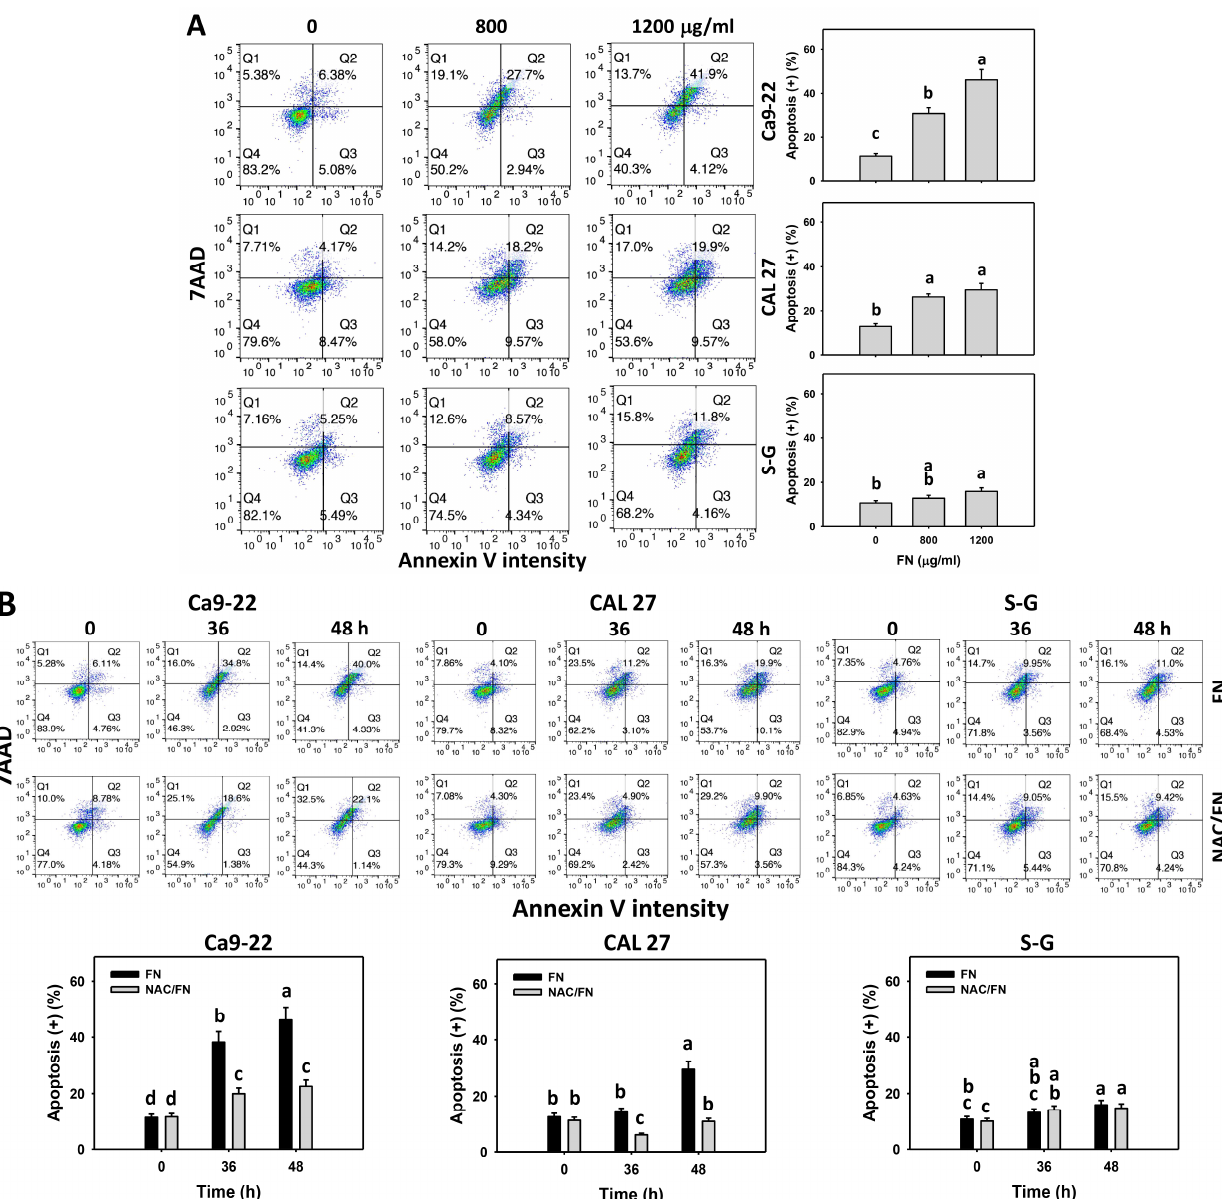
Figure 3. Fucoidan drives apoptosis (annexin V) in oral cancer cells. ( A ) Annexin V histogram and statistical analysis. Oral cancer (Ca9-22 and CAL 27) and non-malignant cells (S–G) were treated with fucoidan (control, 800, and 1200 μg/mL) for 0 and 48 h. Annexin V (+) and 7AAD (+ or −) counts, i.e., Q2 and Q3 quadrants, were regarded as apoptosis (%). It is noted that some of the Q2 cells could be necrotic and not apoptotic. Q4 and Q1 quadrants were regarded as live cells and necrosis (%). For the Q1 quadrant, the DNA staining (7AAD) indicates that the cell membrane has been permea- bilized, but Annexin V does not enter and stain the cells; perhaps it is too big (35 kD), whereas 7AAD (1.27 kD) is small enough to enter. ( B ) The effect of oxidative stress on apoptosis (annexin V) of fucoidan-incubated oral cancer cells. After NAC preincubation or not, cells were treated with fu- coidan (1200 μg/mL) with NAC co-treatment (10 mM) for 0, 36, and 48 h. In general, the actual setting for the windows in ( A ) is based on a similar annexin V intensity (+) (%) to the controls be- tween different cell lines. For NAC pretreatment, the actual setting for the windows in ( B ) is based on the same annexin V intensity of the controls between different cell lines. NAC/fucoidan (NAC/FN) represents the pretreatment with NAC and post-treatment with FN. Data = mean ± SD ( n = 3 experiments). Data with non-overlapping letters reveal significant differences ( p < 0.05). In the example of Figure 3B (Ca9-22 cells), FN at 0, 36, and 48 h, labeled with the connecting letters “d, b, and a”, has significant results, because the letters do not overlap. FN and NAC/FN at 48 h labeled with “a and c” have significant results. In contrast, in the example of Figure 3B (S–G cells), FN and NAC/FN at 36 h labeled with “abc and ab” have nonsignificant results because they overlap with “ab”. The positive control of apoptosis is provided in Supplementary Figure S6.